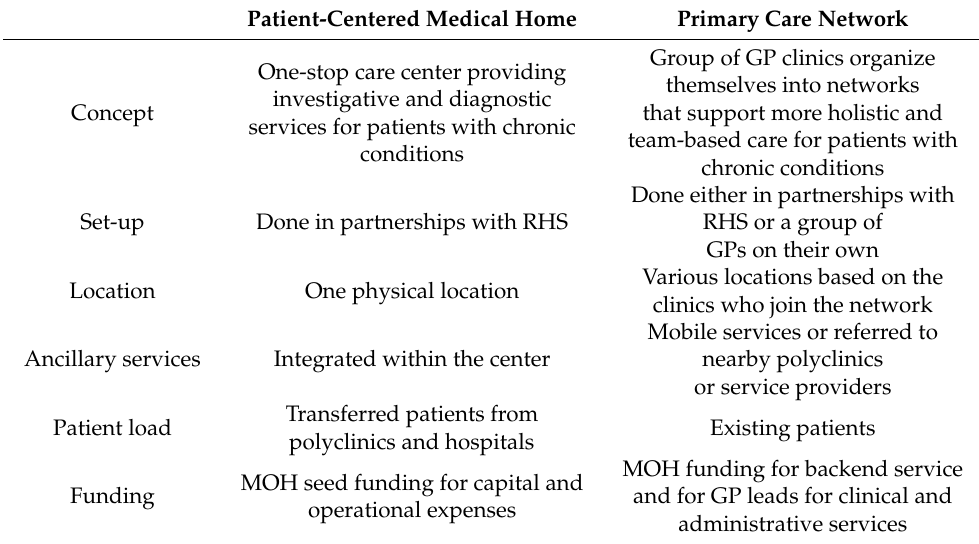
Table 1. Key similarities and differences between patient-centered medical home (PCMH) and primary care network